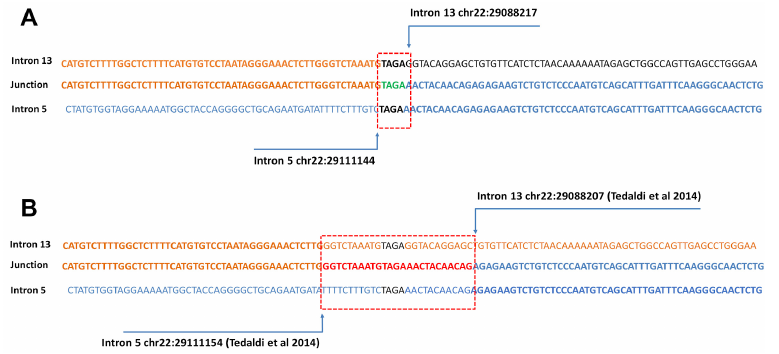
Figure 5. Sequence of exon 6–13 CHEK2 duplication. ( A ) Aligned intron 5 and intron 13 sequences at a duplication junction identified in the proband III:11. The region of homology across the duplication is boxed. ( B ) The panel shows the different breakpoints of the rearrangement reported in the previous paper by Tedaldi et al. [6].